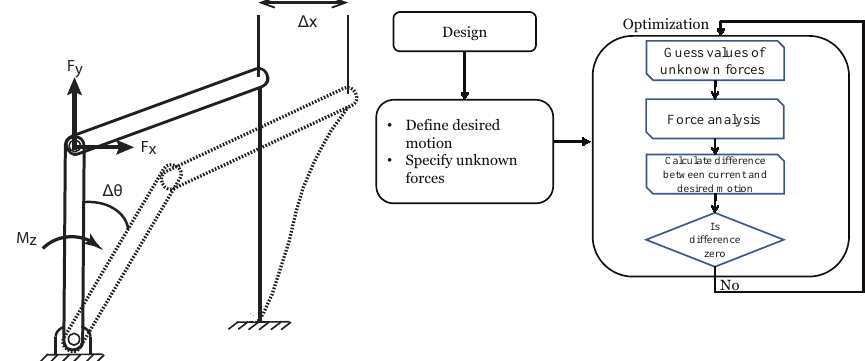
Figure 6. The schematic view (left) and flowchart (right) of the distance analysis problem. (cid:49)x or (cid:49)θ is the given input motion and the magnitudes of unknown loads ( F x , F y and M z ) are the desired outputs of the module.